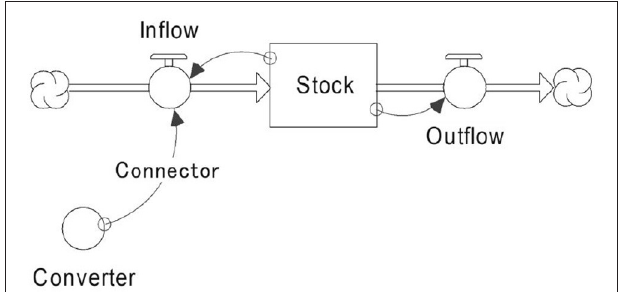
FIGURE 1 | The utility key stakeholders’ level of engagement in decision-making layers of asset management strategy: (1) Visions and Values, (2) Function, and (3) Performance. FIGURE 2 | Building blocks of System Dynamics model.